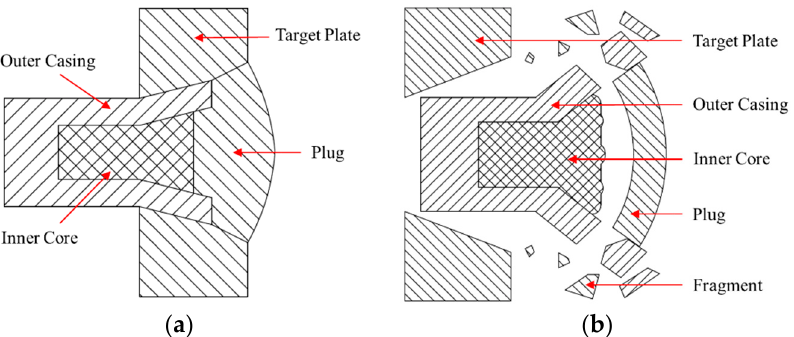
Figure 2. Different penetration state of a PELE projectile: ( a ) initial penetration state; ( b ) completely perforating state.